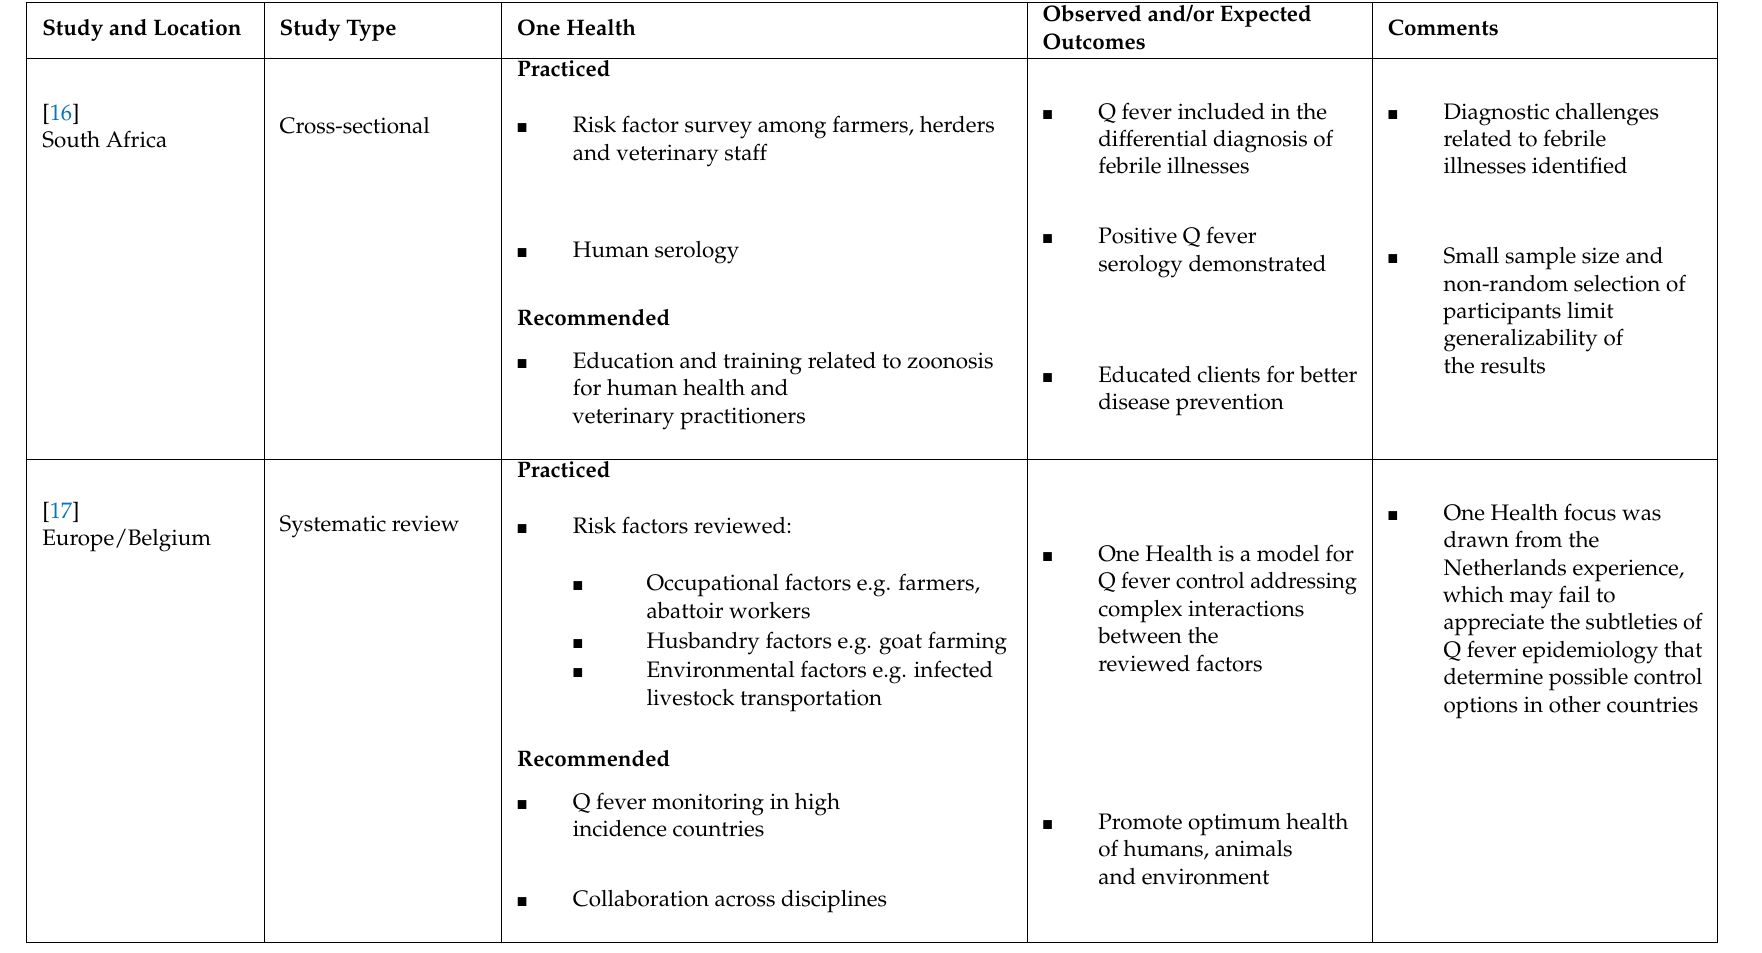
Table 1. Characteristics of the studies that used one or more components of One Health in Q fever prevention and